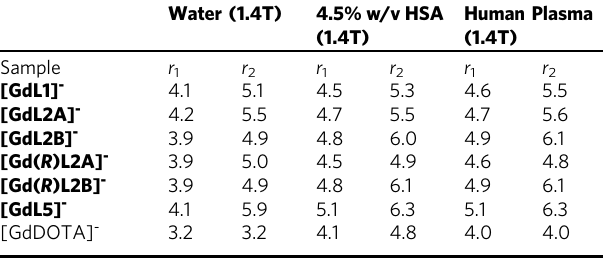
of doublets of doublet), dt (doublets of triple), dtd (doublets of triplets of doublet), dq (doublets of quartet), and m (multiplet). Liquid chromatography-mass spec-